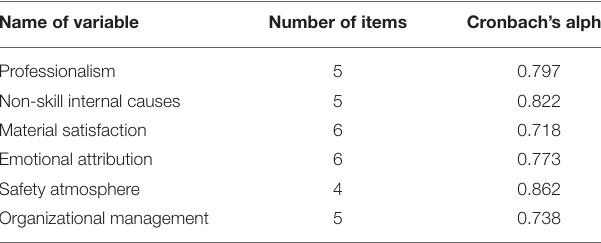
TABLE 5 | Reliability test results of latent variables.